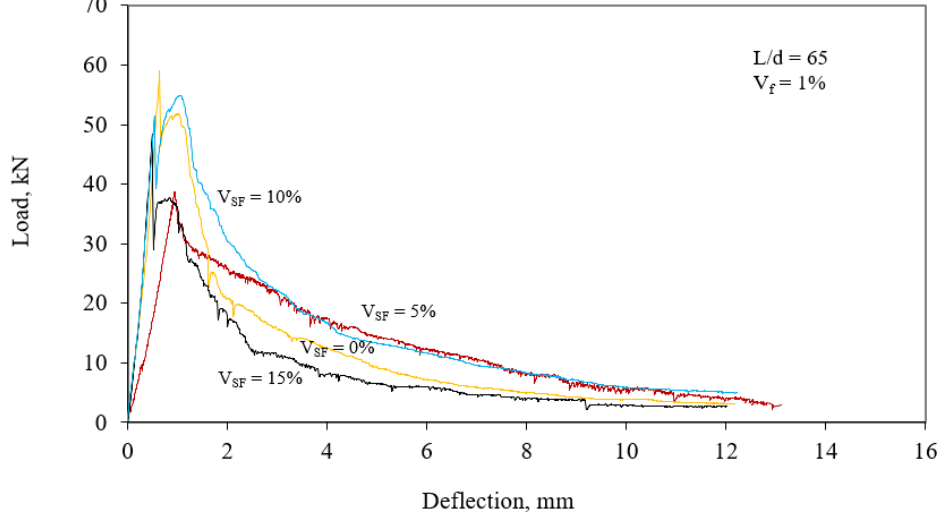
Figure 4. Load – deflection graphs of SFRCs for V f = 1% and aspect ratio of 65.